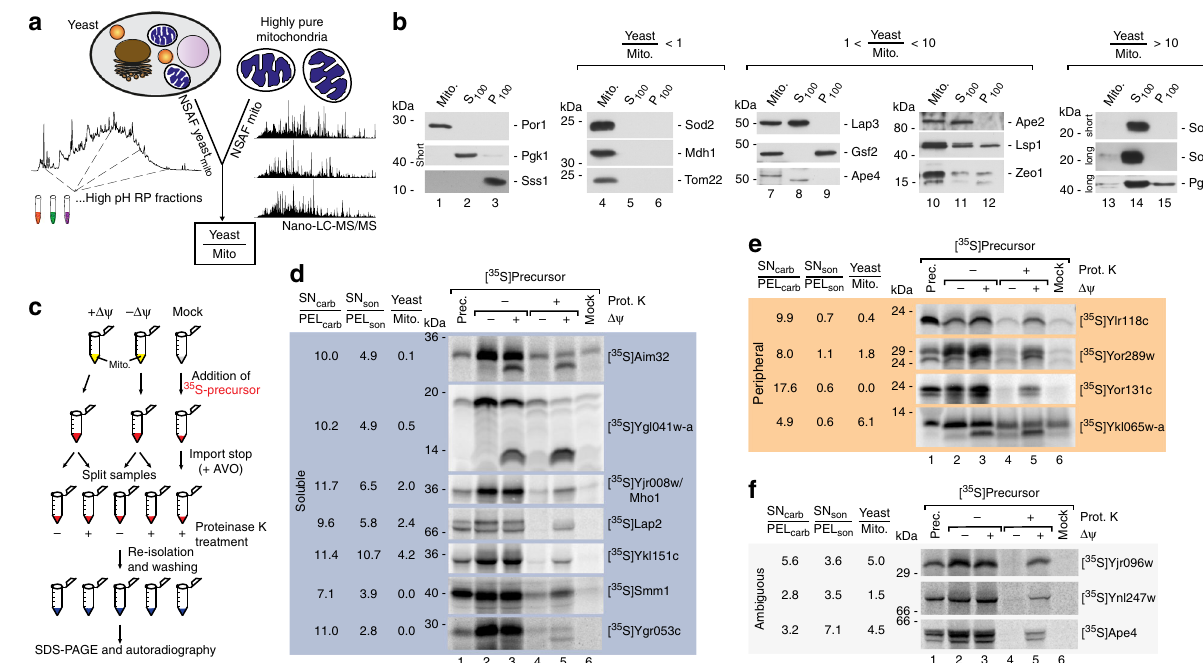
Fig. 3 Validation of mitochondrial localization for novel proteins. a Quantitative assessment of protein abundance in total yeast cells and puri fi ed mitochondria based on spectral counting (normalized abundance factor). Resulting Yeast/Mito ratios indicate presence of proteins either exclusively in mitochondria or in multiple cellular compartments. b Immunoblot analysis of cellular fractions containing pure mitochondria ( Mito ), enriched cytosolic proteins (S100), or microsomal proteins (P100). Por1, mitochondrial marker; Pgk1, cytosolic marker; Sss1, ER marker. long, long exposure time; short, short exposure time. c Schematic overview of in organello import reactions to validate mitochondrial localization. [ 35 S]labeled precursors of candidate proteins were generated by in vitro transcription/translation and incubated with isolated mitochondria in the presence or absence of the membrane potential ( Δψ ) or without mitochondria (Mock). Import reaction was terminated by depletion of the membrane potential and samples were treated with Proteinase K where indicated to remove non-imported precursors. Samples were analyzed by SDS – PAGE and radiolabelled proteins visualized by autoradiography. In case of presequence cleavage upon import a size shift from the precursor to the mature protein can be observed. d In organello import of indicated radiolabelled precursors of novel mitochondrial proteins which localize to the soluble protein fraction. e In organello import of indicated radiolabelled precursors of novel mitochondrial proteins which localize to the peripheral membrane protein fraction. f In organello import of protein candidates from the ambiguous fraction. Prot. K , Proteinase K; prec . precursor; Δψ , membrane potential across the inner mitochondrial